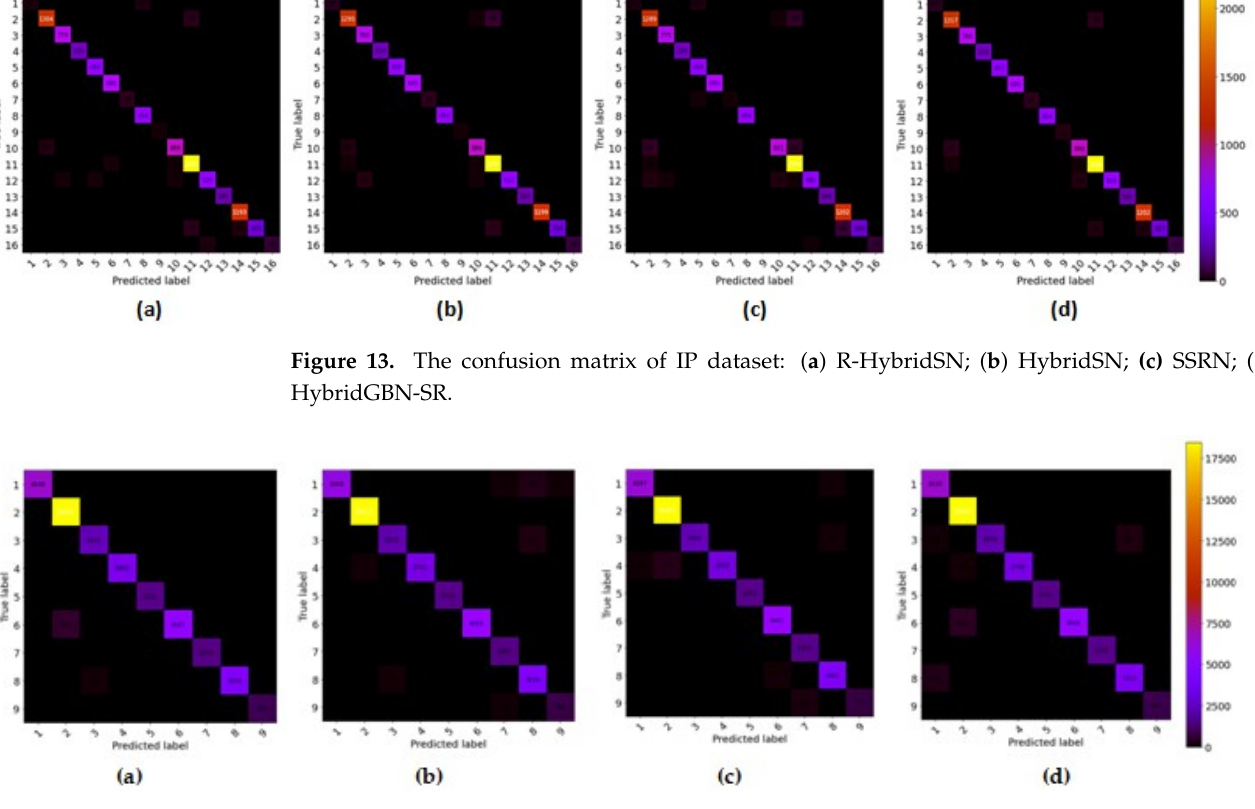
Figure 14. The confusion matrix of UP dataset: ( a ) R-HybridSN; ( b ) HybridSN; ( c ) SSRN; ( d ) HybridGBN-SR.